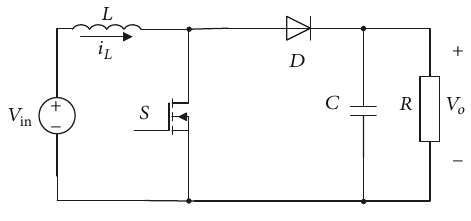
Figure 1: DC-DC Boost